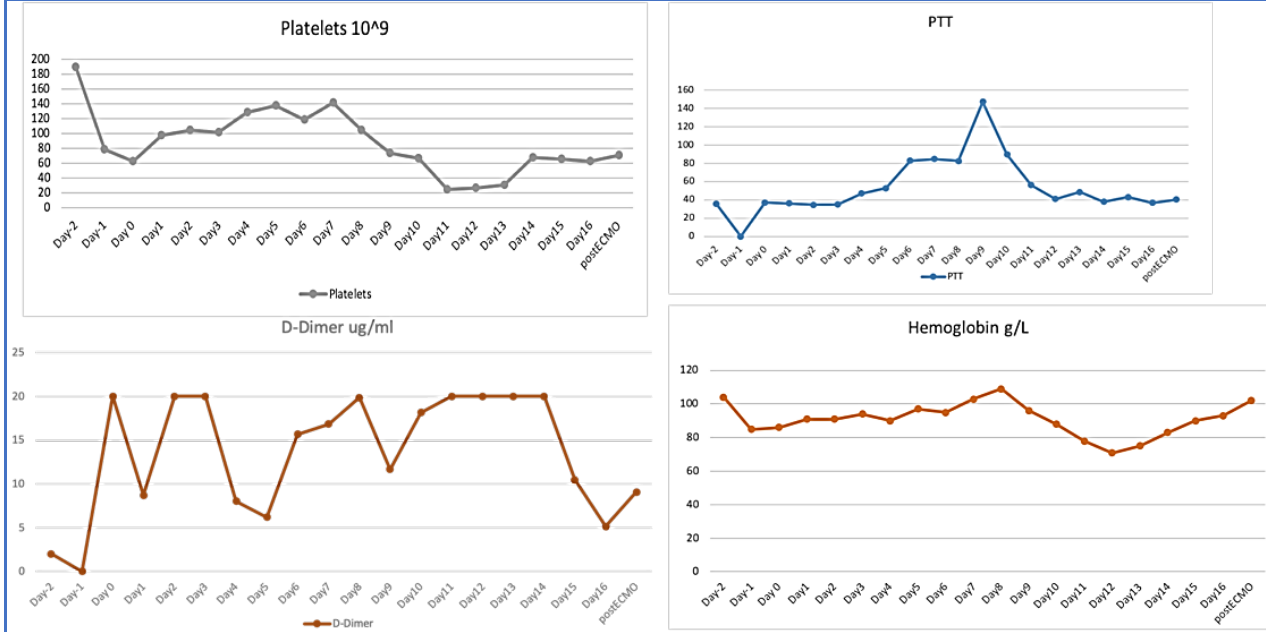
Figure 2. Hemoglobin, Platelets, Fibrinogen and D-Dimer levels 2 days before and during ECMO run. Table 1. Coagulation results Day1 until post-ECMO decannulation.